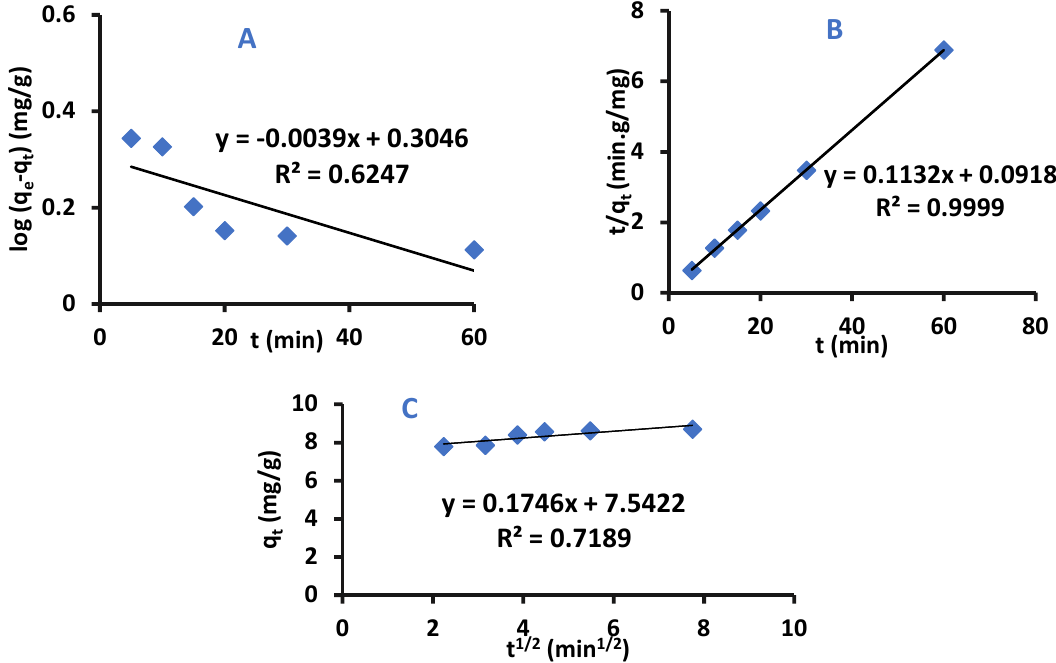
Figure 12. Pseudo-first-order ( A ), Pseudo-second-order ( B ), and Intra-particle-diffusion kinetic ( C ) for difenoconazole removal by Cell-X. (C I : 10 ppm, volume: 10 mL, pH: 7, temperature: 20 °C, dose = 10 mg).